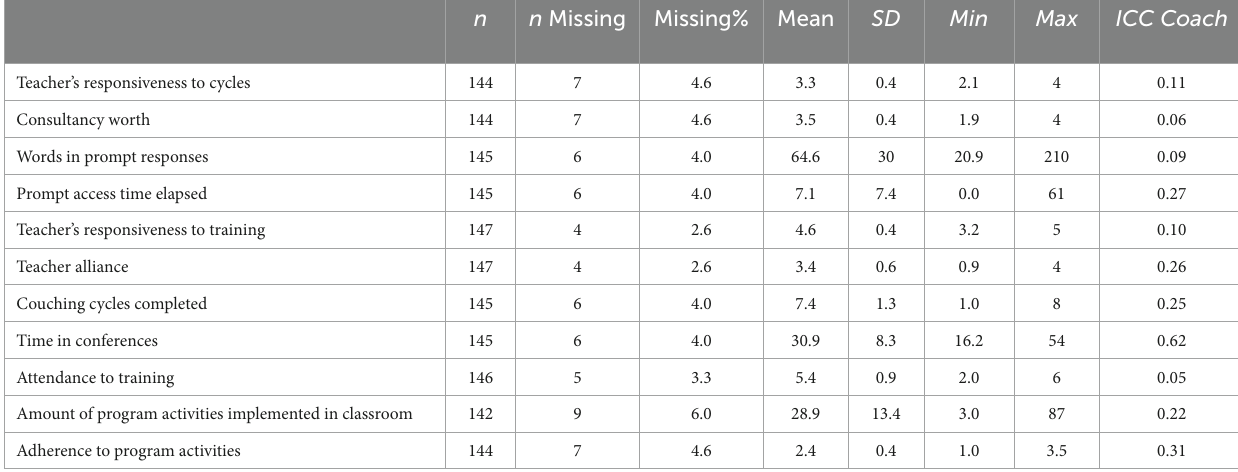
TABLE 4 Descriptive statistics of implementation